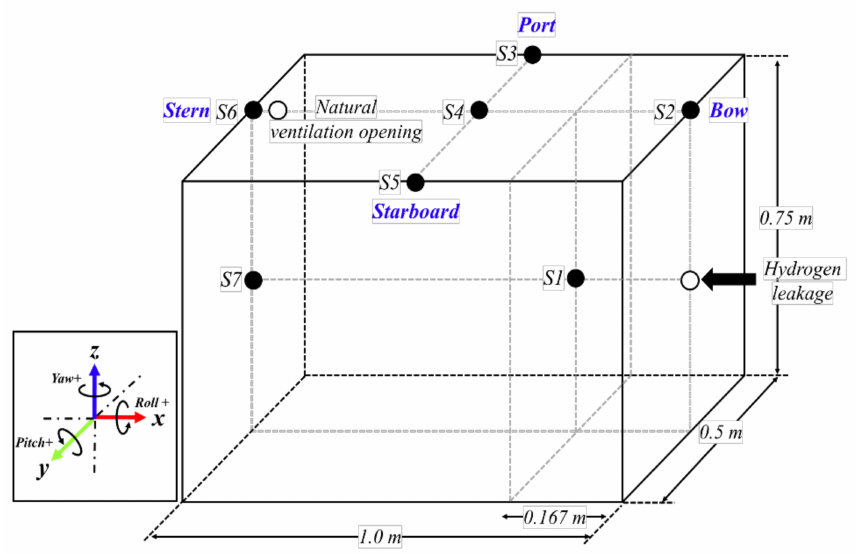
Figure 3. Position of hydrogen sensors: layout and